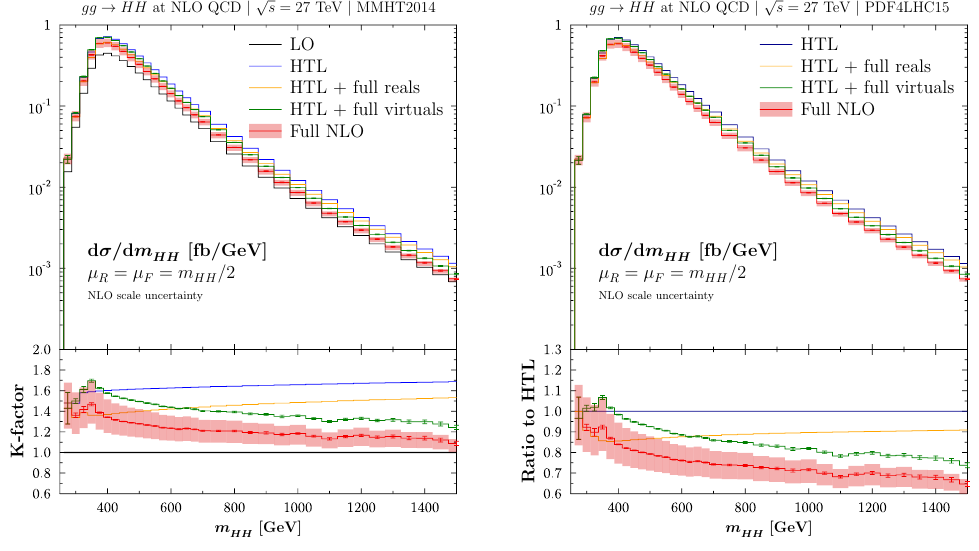
Figure 11 . Same as (cid:12)gure 10 but for a c.m. energy p s = 27 TeV.